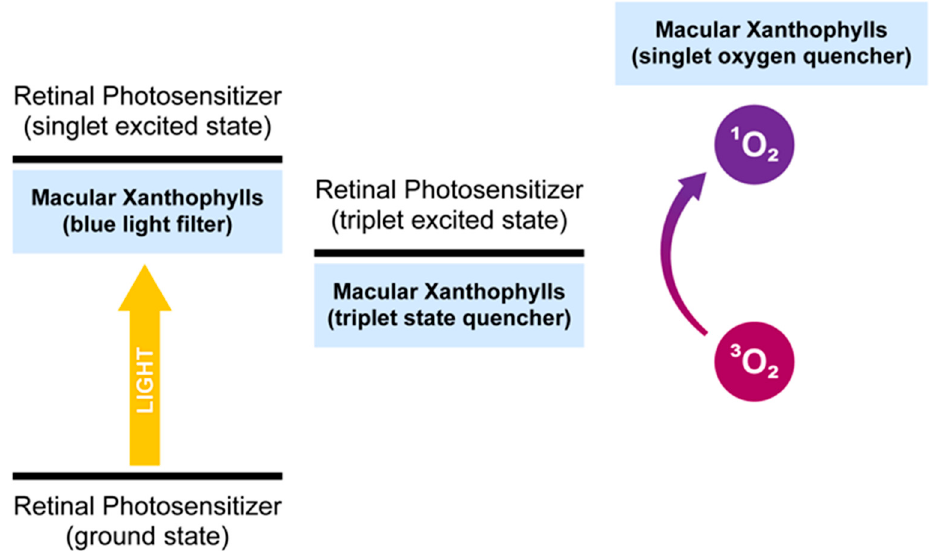
Figure 3. Triple protection of macular xanthophylls against singlet oxygen.